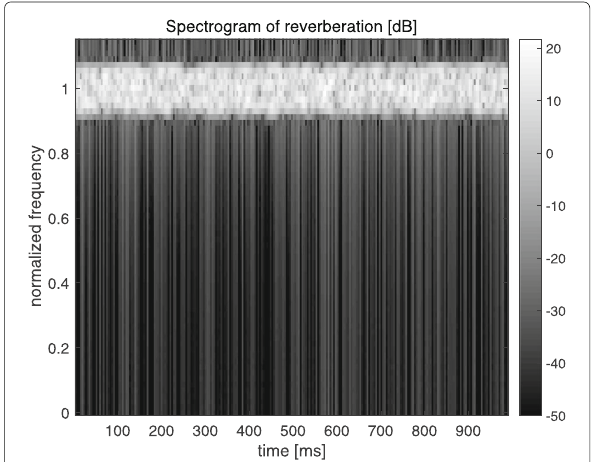
Fig. 3 Spectrogram of simulated reverberation. The spectrum has a wideband and is distributed over time, undermining target